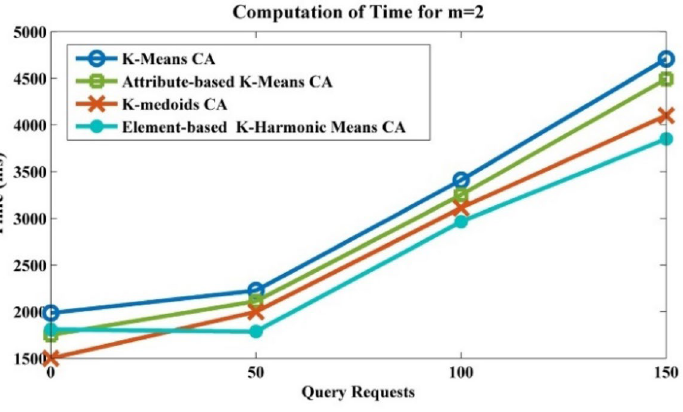
Figure 7. Computation of time for m = 2.